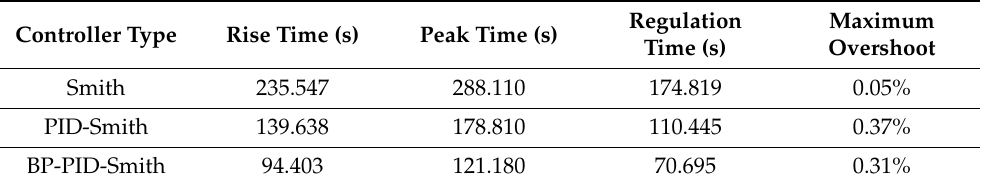
Table 4. Comparison of the dynamic performance of the three controllers at a fertilizer flow rate of 0.58 m 3 /h.